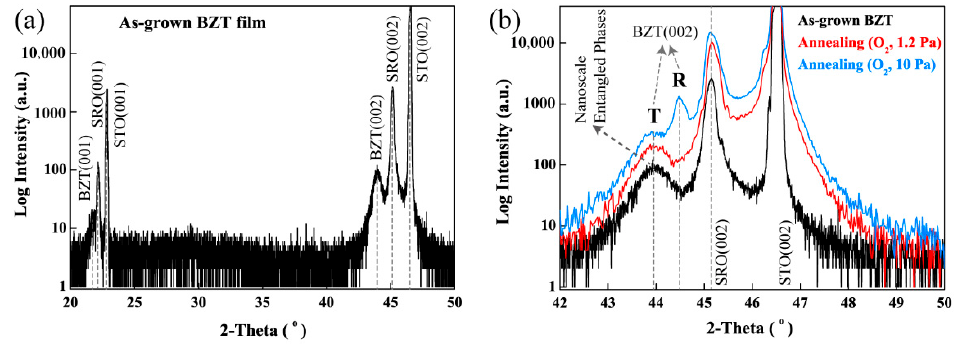
Figure 1. XRD 2 𝜃 -scan patterns of ( a ) the as-grown BZT film (1.25 μ m thick); ( b ) the BZT films annealed at 650 °C and in a pure O 2 (1.2 Pa or 10 Pa) atmosphere, in comparison with that of its as- grown